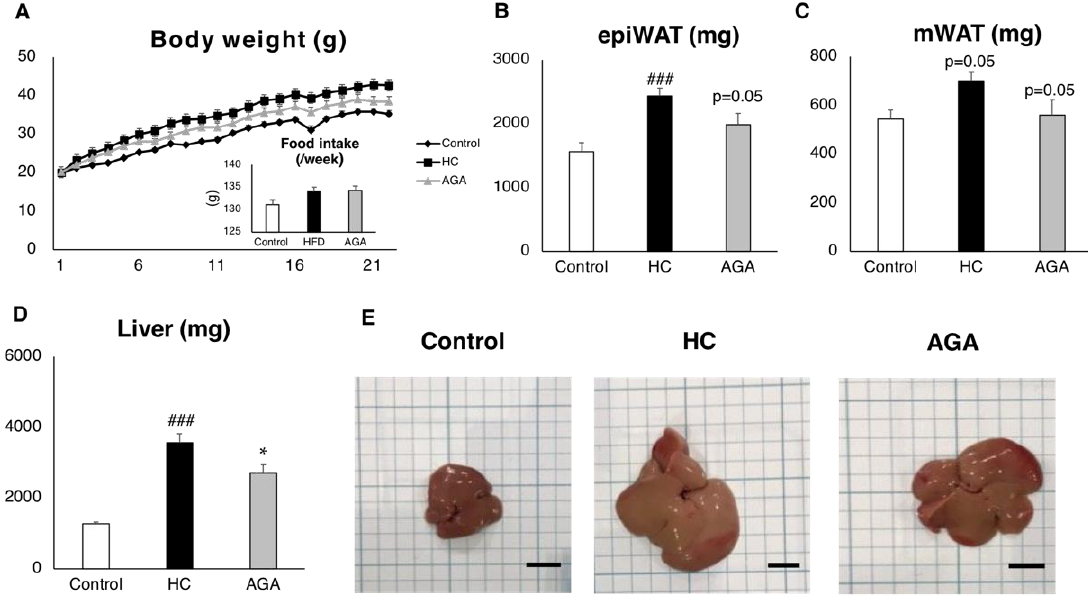
Figure 1. Agaricus brasiliensis KA21 (AGA) prevents non-alcoholic steatohepatitis (NASH) onset induced by high-cholesterol (HC) diet. Control diet (Control), HC diet, and high-fat and high-cholesterol + 5% AGA. ( A ) Weight change; ( B ) epididymal fat; ( C ) mesenteric fat; ( D ) liver weight; ( E ) liver biopsy pictures’ scale bar shows 10 mm. Data are presented as the mean ± SEM values. n = 7 mice per group. Statistical analysis was performed by one-way ANOVA, followed by Bonferroni’s post-hoc test. * p < 0.05; ### p < 0.001 versus mice in the HC group ( # significant differences for HC versus Control, * significant differences for HC versus AGA).